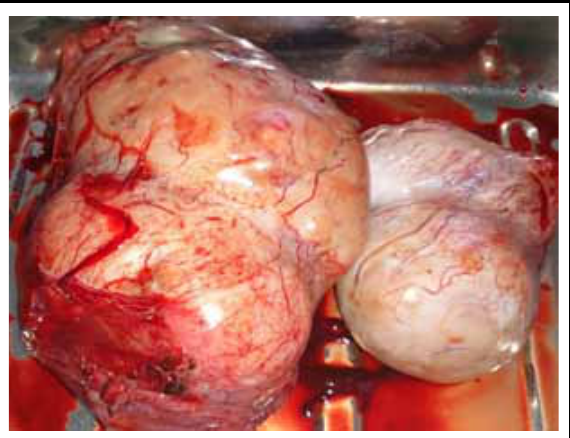
Figure 3. testicular mass after removal in the opera- tion theatre